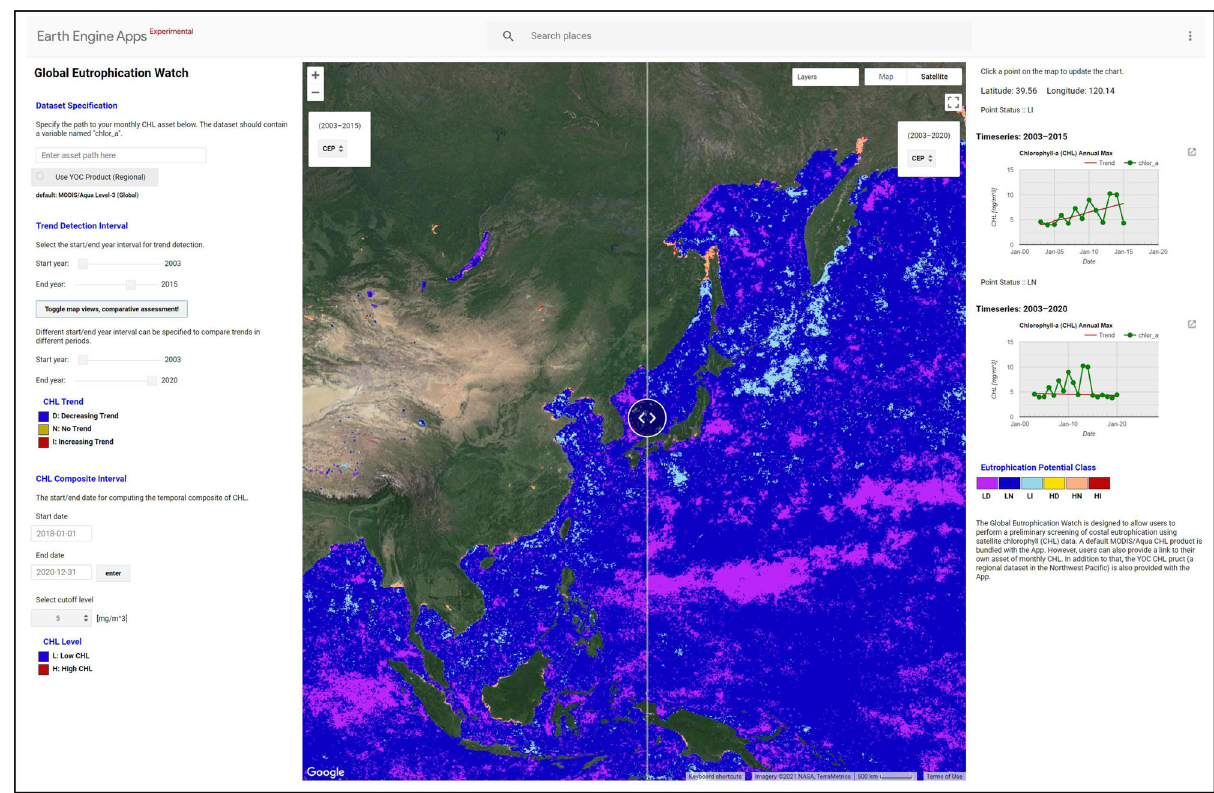
Fig. 3 Global eutrophication watch app interface. The left panel shows the control panel of the app. The map of CEP in the NOWPAP region based on MODISA global dataset is shown in the middle. The right panel shows the CHL max time series of a select point on the map. The CEP classes are also